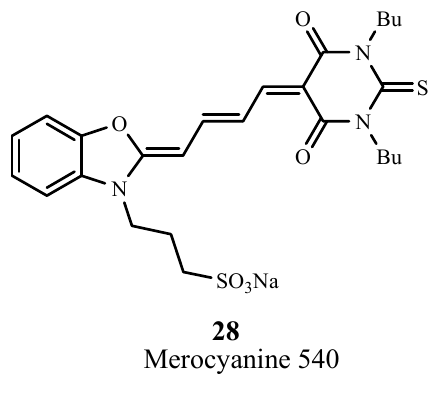
Figure 19. Example of a merocyanine PDT